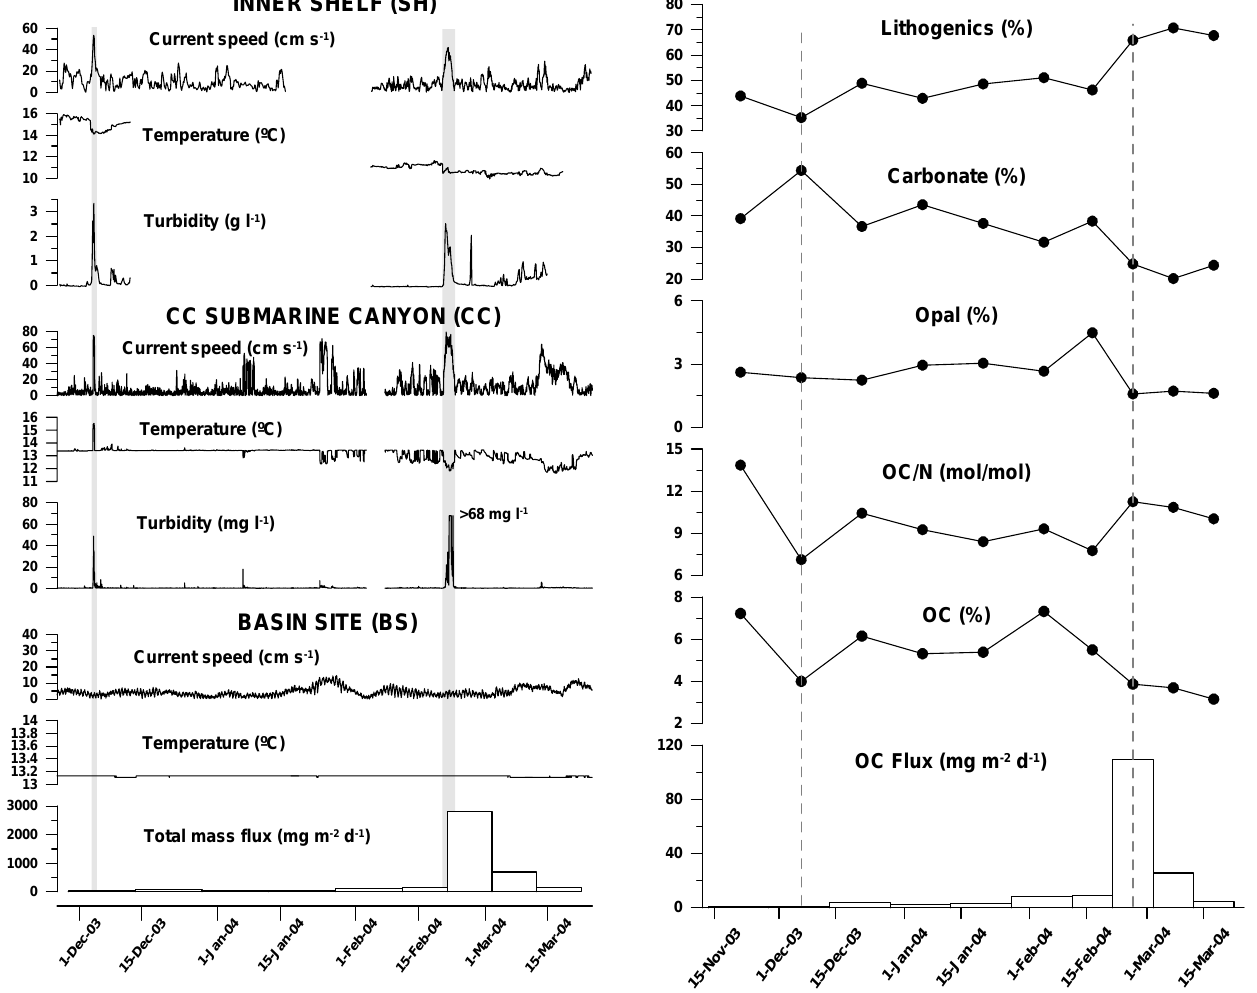
Fig. 4. Time series of lithogenics content, calcium carbonate content, Opal, OC/N ratio, organic carbon content and organic carbon flux at the basin site. Dashed lines represent the trap collecting intervals during which severe storms